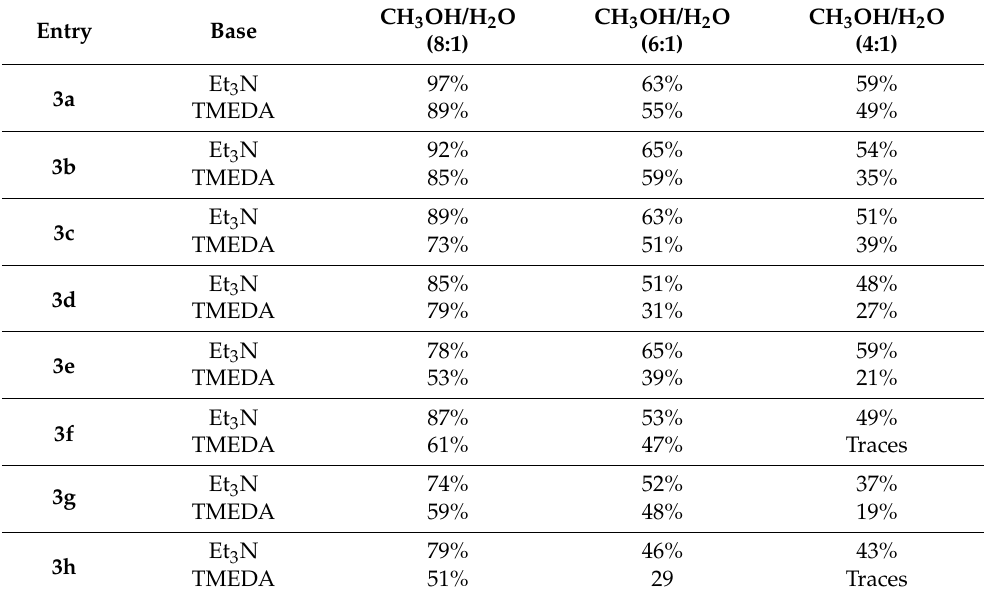
Table 2. Effect of (CH 3 -OH/H 2 O) mixed solvent ratio by using Cu(OAc) 2 .H 2 O on yield of compounds ( 3a – 3h